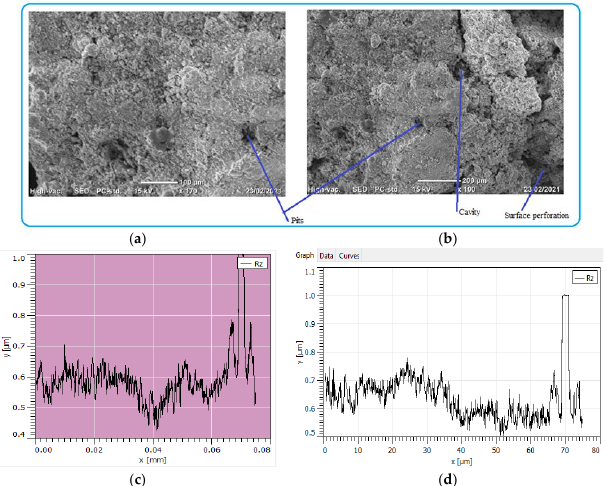
Figure 11. SEM images of localized and uniform corrosion morphologies of GS pipe: ( a , b ), and ( c , d ) are showing cross-sectional details of ( a,b ).